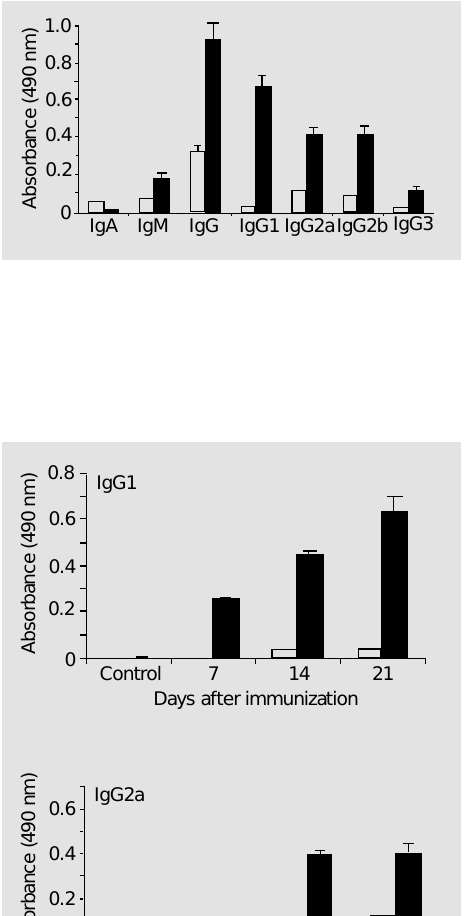
Figure 6 - Enumeration of spleen cells producing anti-BCG anti- bodies. Spleen cells were col- lected 21 days after iv immuni- zation with O-BCG (open col- umns) or ID-BCG (filled col- umns). The IgG1, IgG2a, IgG2b and IgG3 isotypes were identi- fied by the spot-ELISA tech- nique. Each point represents the mean ± SD of cells from a group of 5